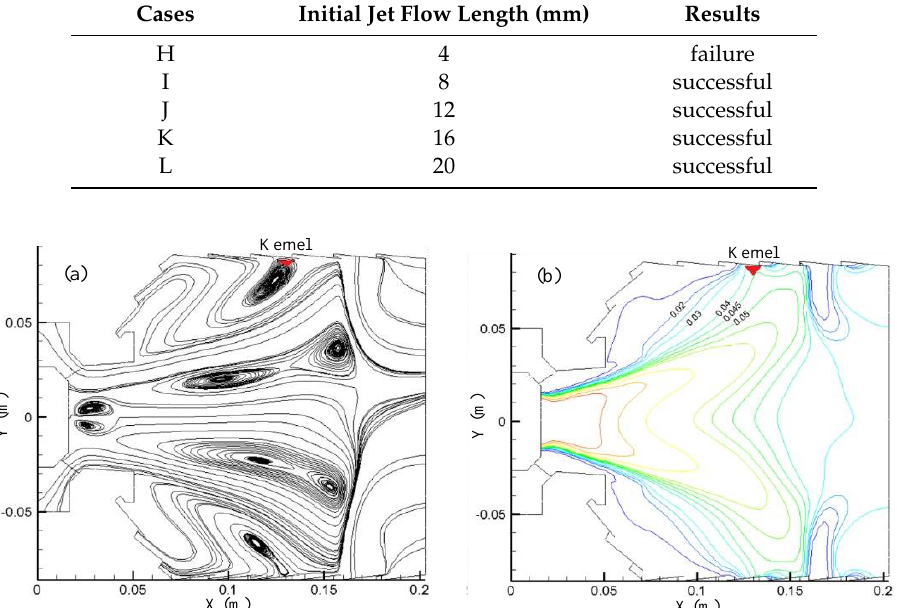
Figure 12. ( a ) Streamlines and ( b ) fuel mass fraction distributions.